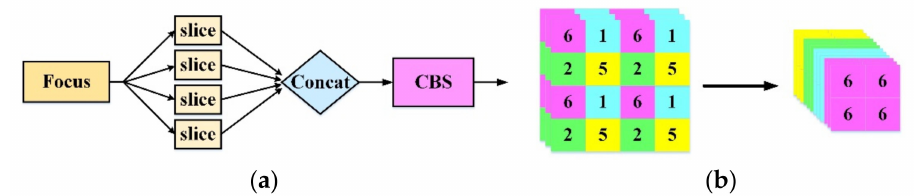
Figure A2. The focus network structure and its feature map transformations: ( a ) focus network structure, ( b ) the transformation of feature maps.